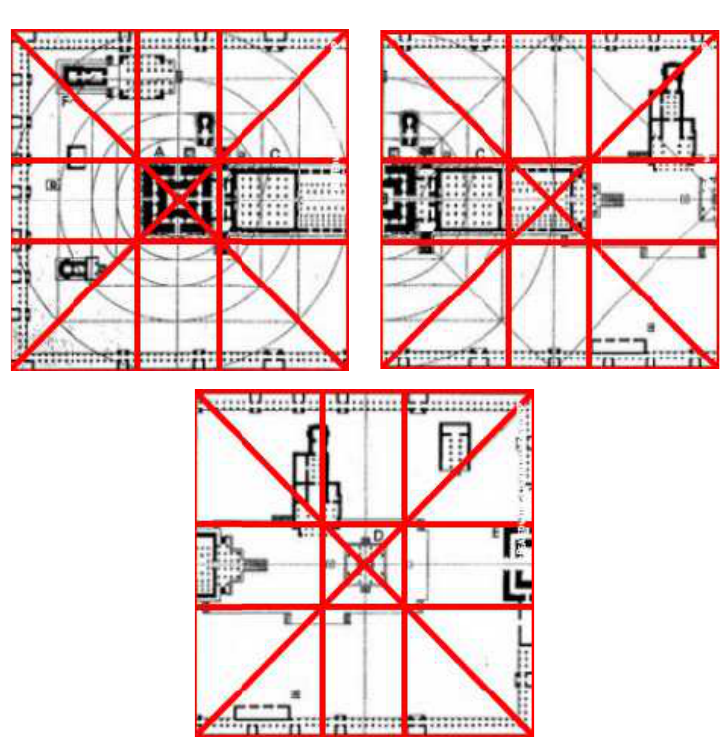
Figure 8. Golden ratio of the Brihadeeshwarar temple using Phi Grid